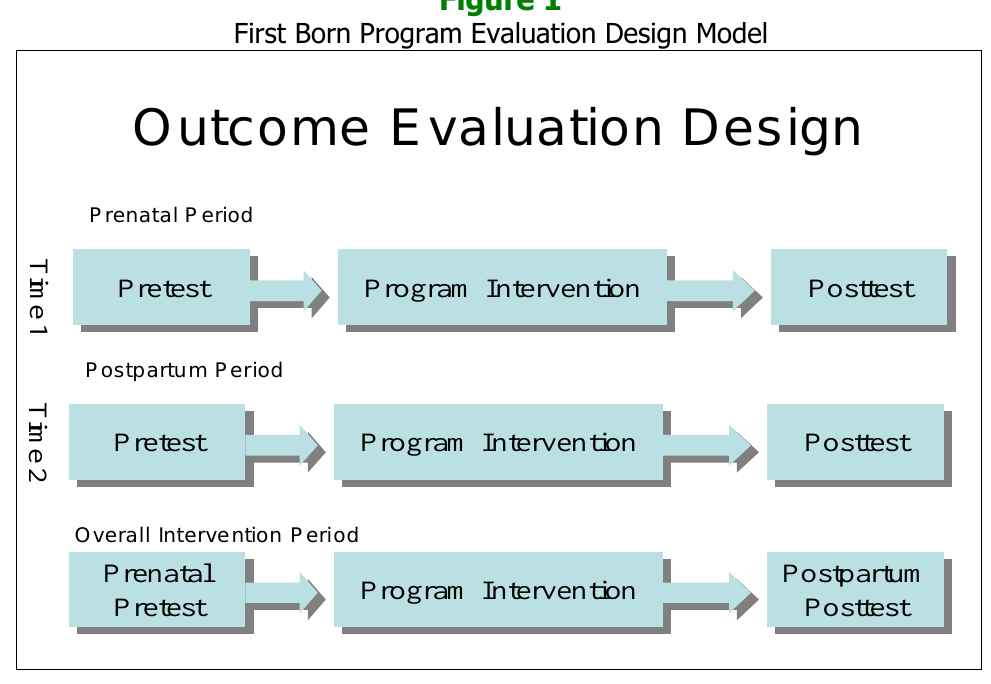
First Born Program Evaluation Design